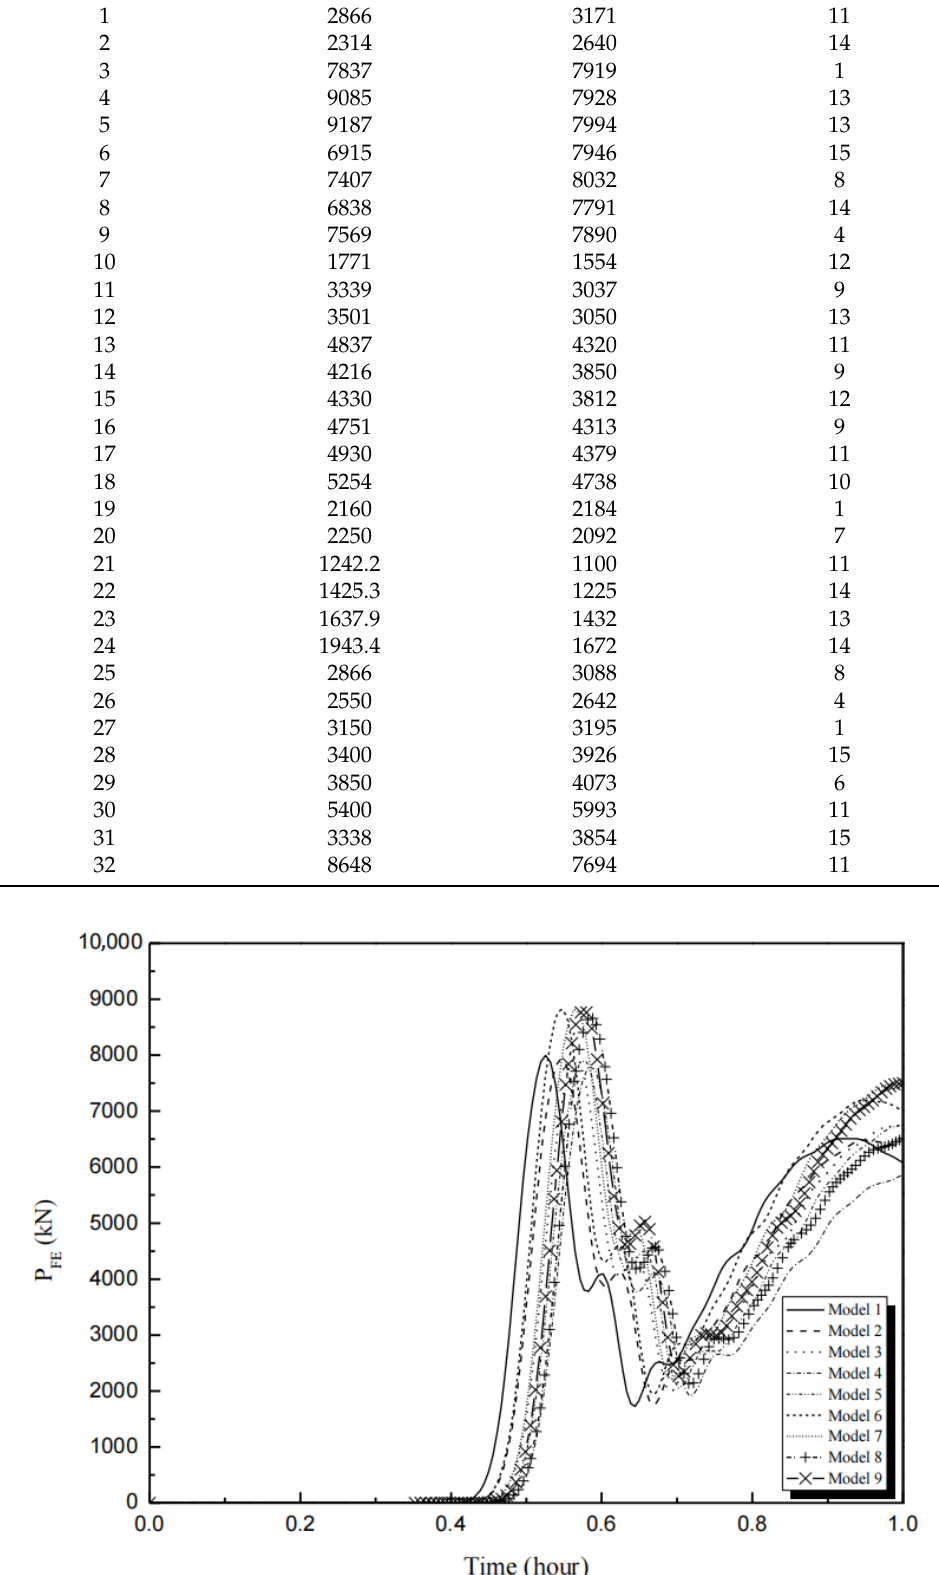
Figure 3. Axial strength versus time for model numbers 1–9.